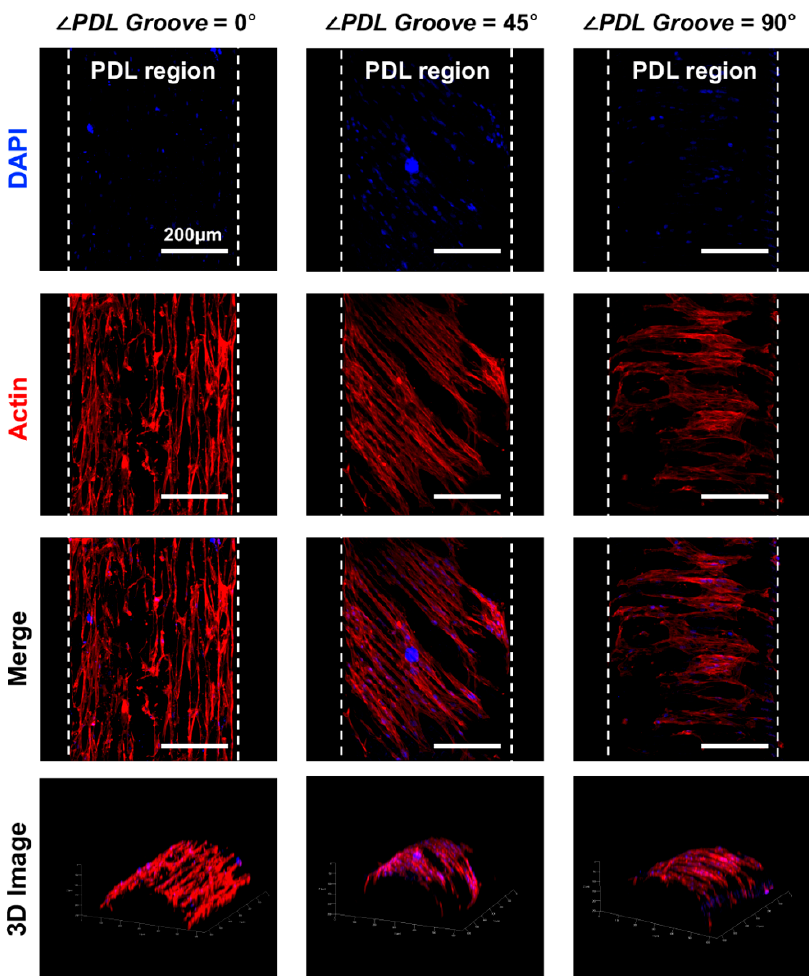
Figure 3. The angulations and orientations of rat PDL cells were qualitatively analyzed using the fluorescence staining method with cell nuclei and actin filaments after 7-day cultures. Nuclear angulations and cytoskeleton polarities (or cell orientations) can be qualitatively determined to the reference, which was determined to be the parallel direction to the PDL-guiding architectures. White dash-lines represented PDL-guiding architecture border lines. Scale bars: 200 µm.